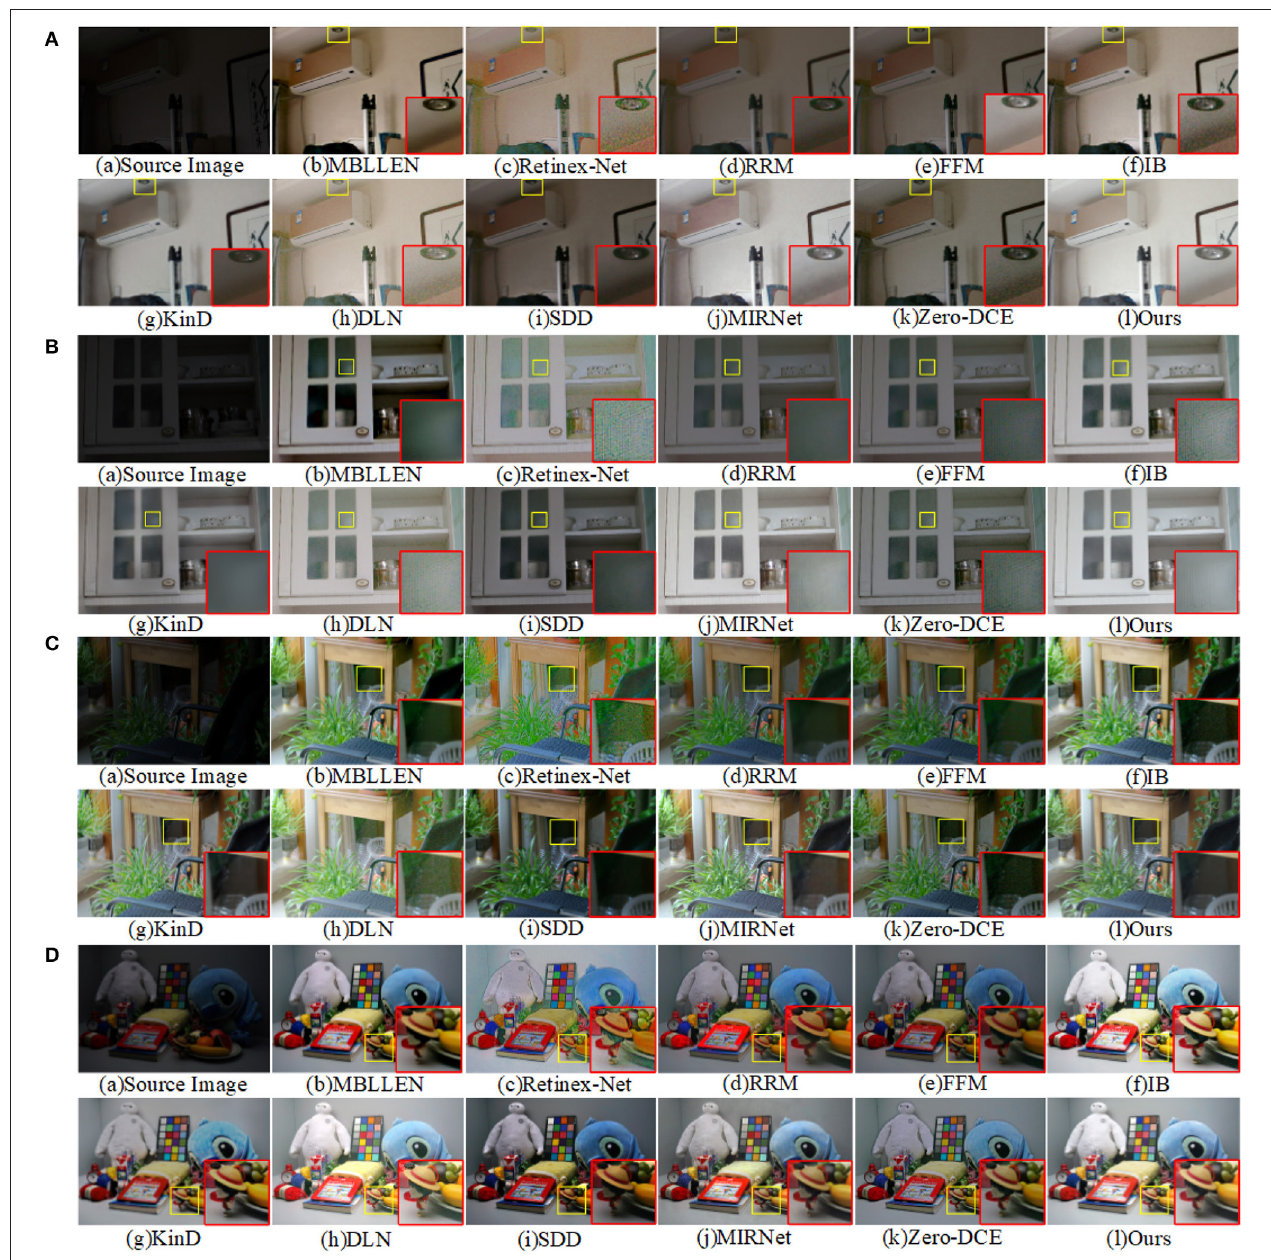
FIGURE 7 | Four images were extracted from the LOL dataset to compare the visual effects of our method with other low-light enhancement methods. (A) is the original image, (B–K) is the image enhanced by other methods, and (I) is the image enhanced by our method. The yellow box is the selected detail content, and the red box is the enlarged